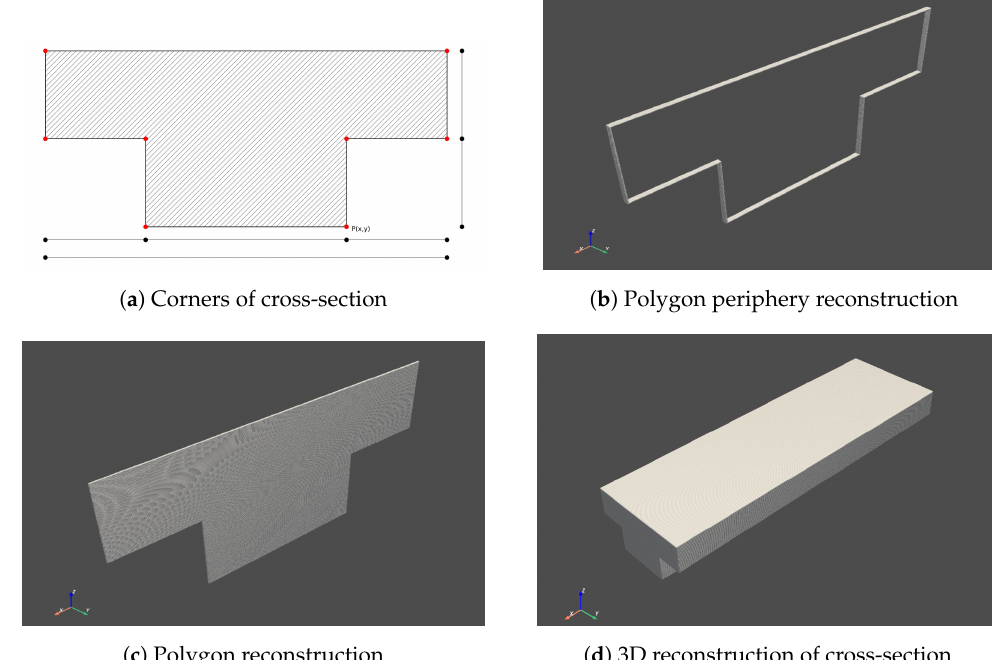
Figure 5. point cloud reconstruction of the ( a ) ROI selected; ( b ) shows the periphery point cloud of the polygon and ( c ) shows a fully filled point cloud of the polygon; ( d ) is a stack of layers of point cloud.